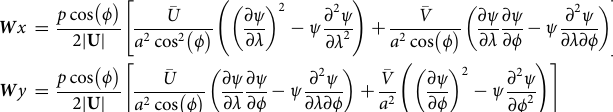
(AMPS) that is operationally run by the National Center for Atmospheric Research (NCAR), USA 56 . More details of the Polar-WRF and its components can be found in refs. 54,57,58 and citations therein. Our modeling experiment was conducted over the Antarctic Peninsula with two nested domains at 0.4° (~45 km) and 0.13° (~15km) spatial resolutions on a polar stereographic projection. Initial and lateral boundary conditions including SST fi elds and initial soil parameters are provided by ERA-Interim at 6-hourly intervals with a grid spacing of 0.75°× 0.75°. The sea-ice data are based on the 25-km resolution Bootstrap dataset 59 . Land-type and topography information for the model are from the United States Geological Survey land-use data and GTOPO30 elevation data, respectively. In this study, we use only 15-km simulation outputs from the inner domain, which is centralized on the Antarctic Peninsula and Larsen Ice Shelf and has 208× 190 grid cells. This domain employs 61 vertical levels between the surface and the model top at 10 hPa. The simulations were performed using: (1) the new version of the rapid radiative transfer model 60 for general circulation models (RRTMG) for both shortwave and longwave radiations, (2) the Morrison double-moment microphysics scheme 61 , (3) the Mellor – Yamada – Janjic (MYJ) boundary layer scheme 62 , (4) the Grell − Freitas ensemble cumulus scheme 63 , and (5) the Noah-MP land-surface model 64,65 . More information about the model con fi guration and setup as well as its ability to capture recent temperature trends can be found in ref. 66 .